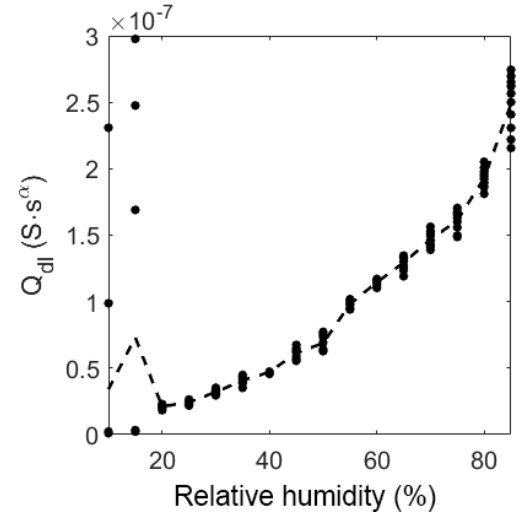
Figure 11. Prefactor of CPE ion over relative humidity at room tem- perature. The dots represent the value of the fit of each measure- ment. The dashed line represents the mean of the dots.